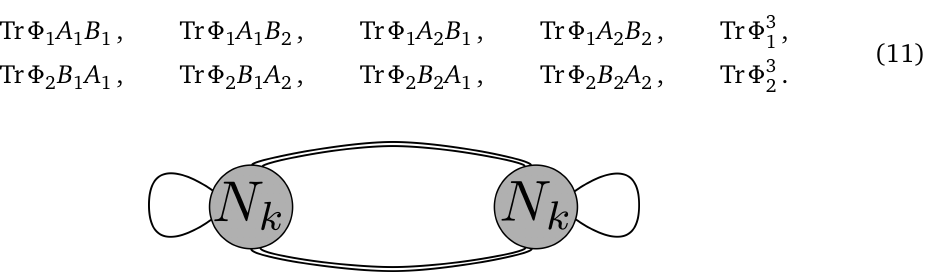
orbifold of the 4d N = 4 SYM theory 2